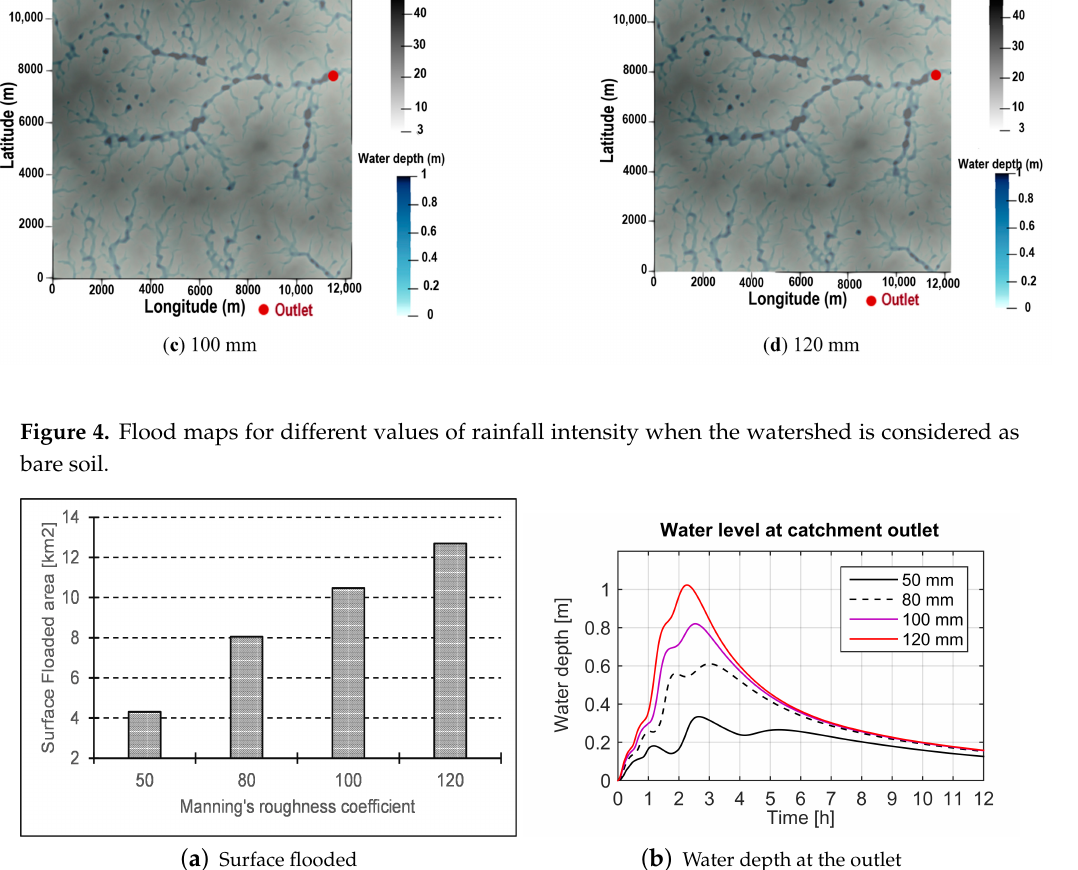
Figure 5. ( a ) Cumulative flooded surface over the watershed and ( b ) water depth at the watershed outlet for each rainfall